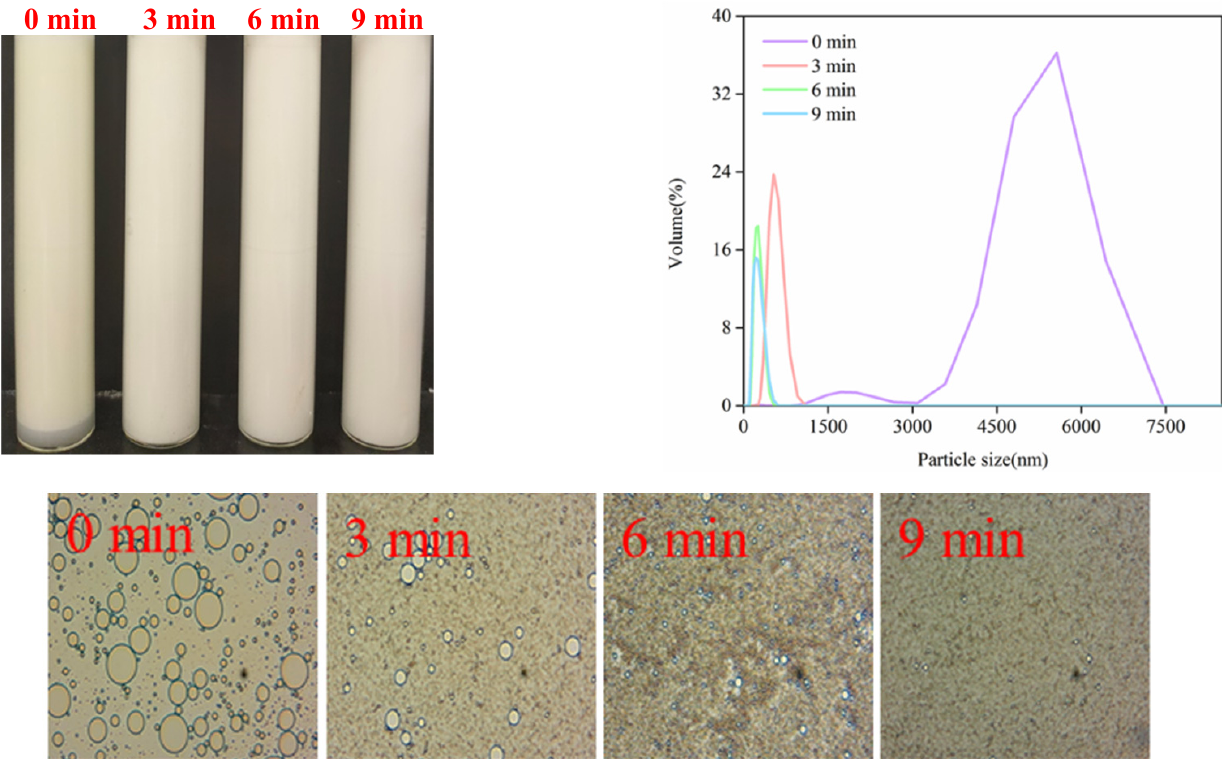
Figure 7. Effect of thermal treatment on the visible appearance, particle size distribution and microstructure of SC-coated O/W emulsions by a high-intensity ultrasound treatment. According to the above results, a proposed mechanism is shown in Figure 9. After the ultrasound treatment, SC had some physicochemical and structural changes, including reduced particle size, increased surface hydrophobicity and fluorescence intensity, exposure of tyrosine and tryptophan to the protein surface, and the formation of small aggregates and a loose structure. During the ultrasound homogenization process, more SC can be adsorbed to the interface of oil droplets, forming the stability of emulsions due to the above physicochemical and structural changes of SC. Under various environmental stresses, the stability of ultrasound-treated emulsions inhibited flocculation and coalescence. High- intensity ultrasounds enhanced SC-coated O/W emulsion